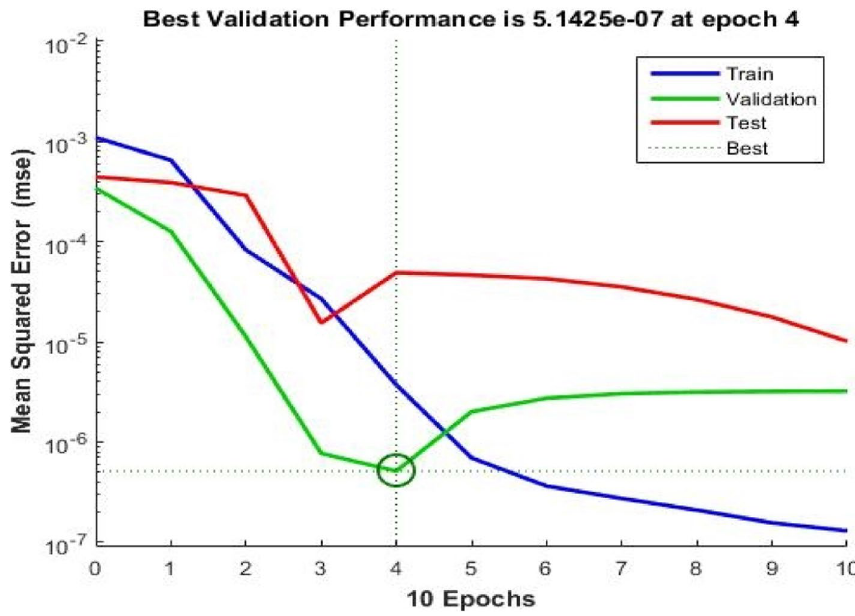
Fig. 14 ANN performances of the training record at the air inlet at (130–190)